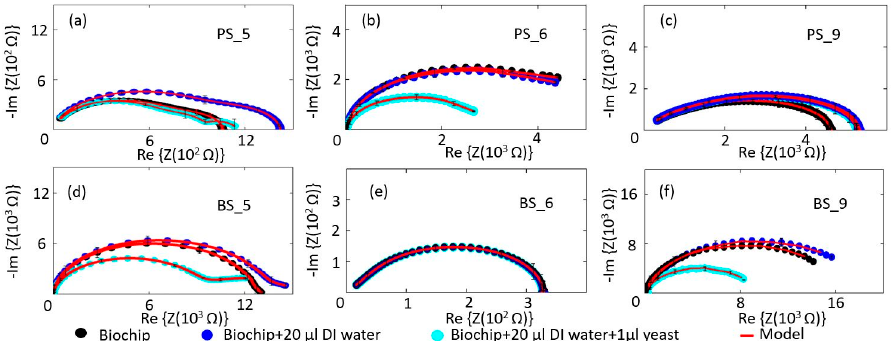
Figure 4. Measurement and modeling results for the ( a – c ) phosphor-implanted biochips, biochips with 20 µL DI water, biochip with 20 µL S. cerevisiae and ( d – f ) boron-implanted biochips, biochips with 20 µL DI water, biochip with 20 µL S. cerevisiae . Sensitivity level of the biochip to medium